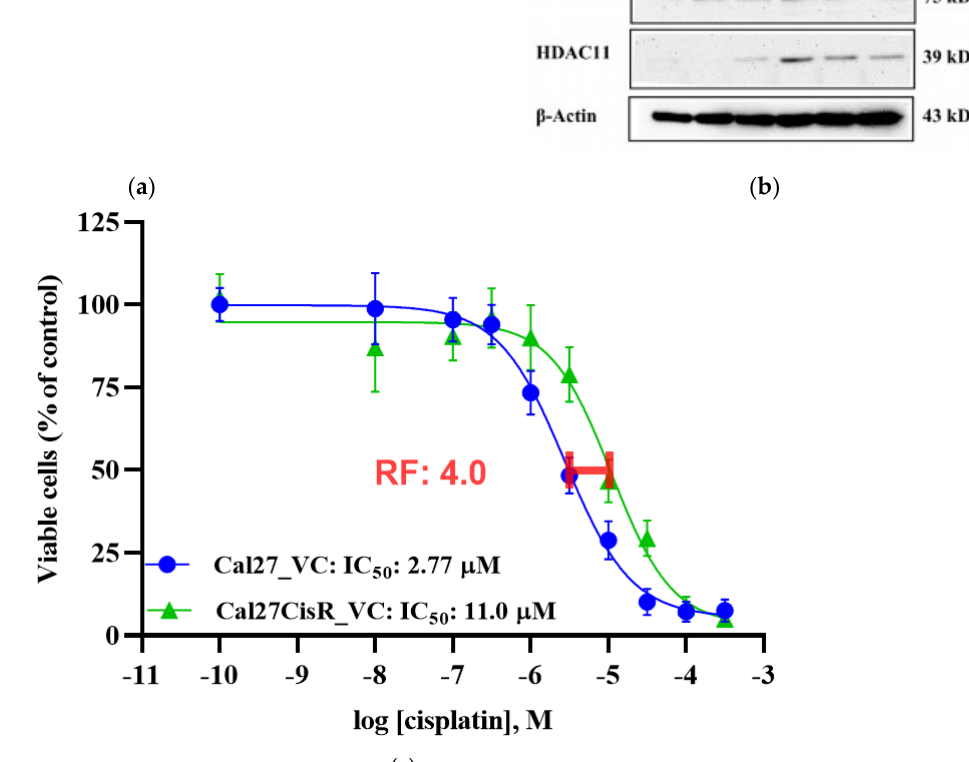
Figure 1. ( a ) HDAC isoform gene expression in Cal27_VC and Cal27_HDAC4. Data shown are RPKM (reads per kilobase per million mapped reads) expression values normalized from three independent RNA sequencing experiments. The white bars represent the vector control cell line Cal27_VC, the black bars represent the HDAC4 overexpression clone Cal27_HDAC4. ( b ) Representative Western blot analysis of HDAC protein expression in vector control (VC), HDAC4 and HDAC5 overexpression clones of sensitive Cal27 and cisplatin resistant Cal27CisR cells. ( c ) Cisplatin concentration effect curves and IC 50 values for Cal27_VC and the corresponding cisplatin resistant subline Cal27CisR_VC measured by MTT assay. Resistance factor (RF) is 4-fold.